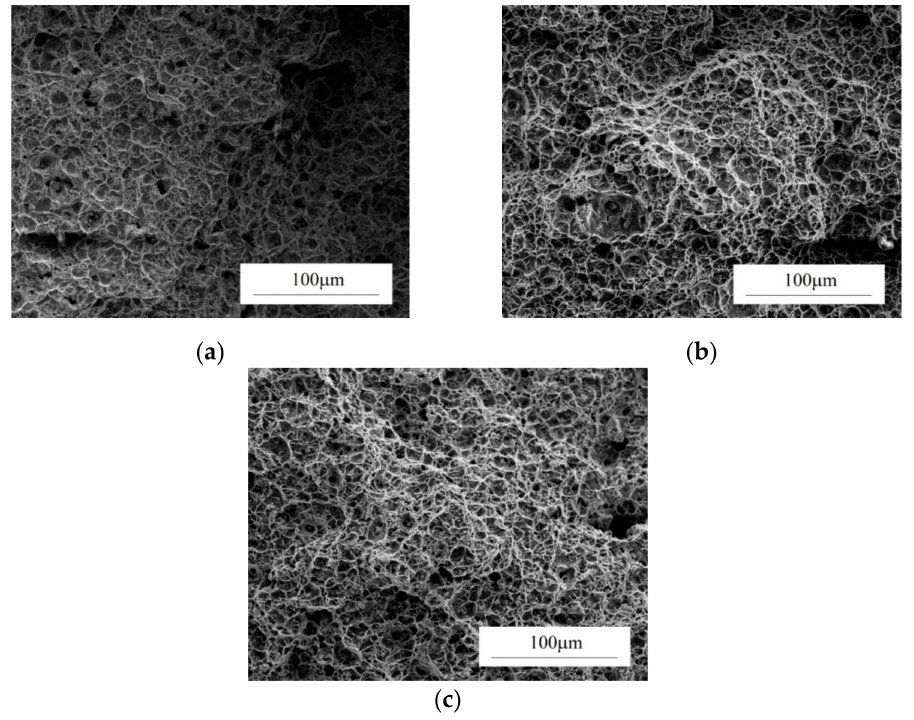
Figure 10. Fracture surfaces of notched tensile specimens made of S355J2G3 steel, subjected to various stress triaxialities: ( a ) 1.345; ( b ) 0.739; ( c )